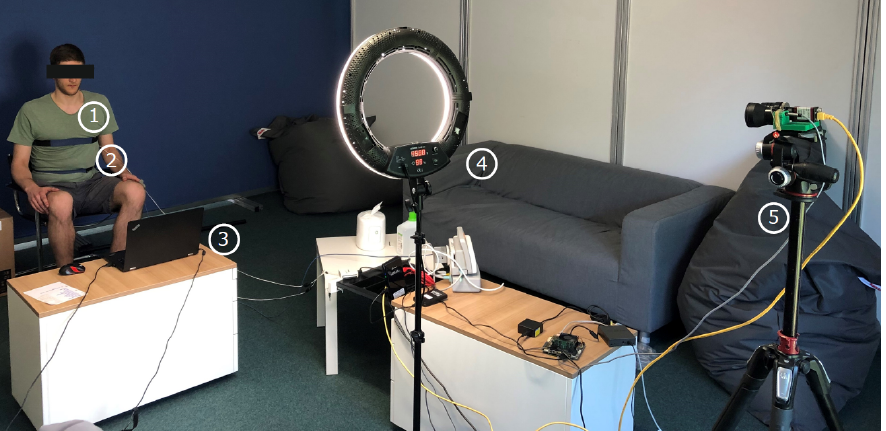
Figure 3. Experimental setup: A voluntary subject is sitting in a chair, wearing two respiratory belt sensors around the thorax ( 1 ) and abdomen ( 2 ). A computer ( 3 ) displays predefined breathing patterns and stores the video frames of an RGB and thermal camera ( 5 ). Illumination is ensured by using a ring light ( 4 ).